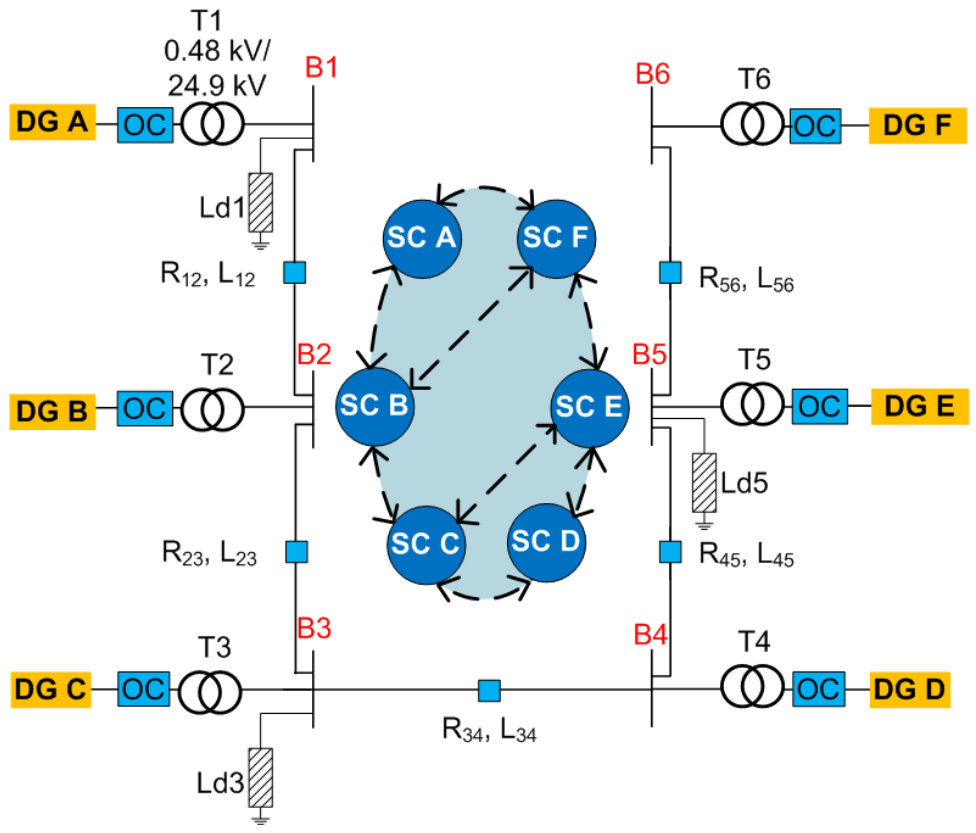
Figure 18. Islanded radial AC microgrid with six DGs in addition to transformers and a meshed cyber